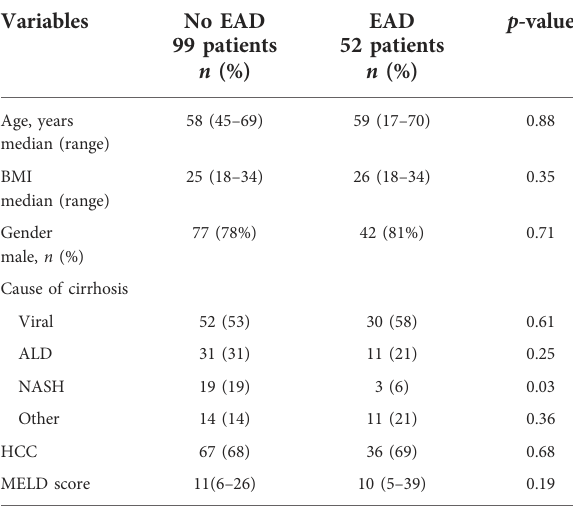
TABLE 8 Recipient characteristics for patients who developed EAD compared who did not develop